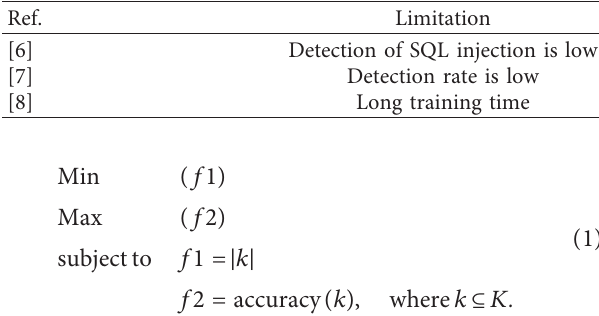
Table 1: IDS existing work. Ref.